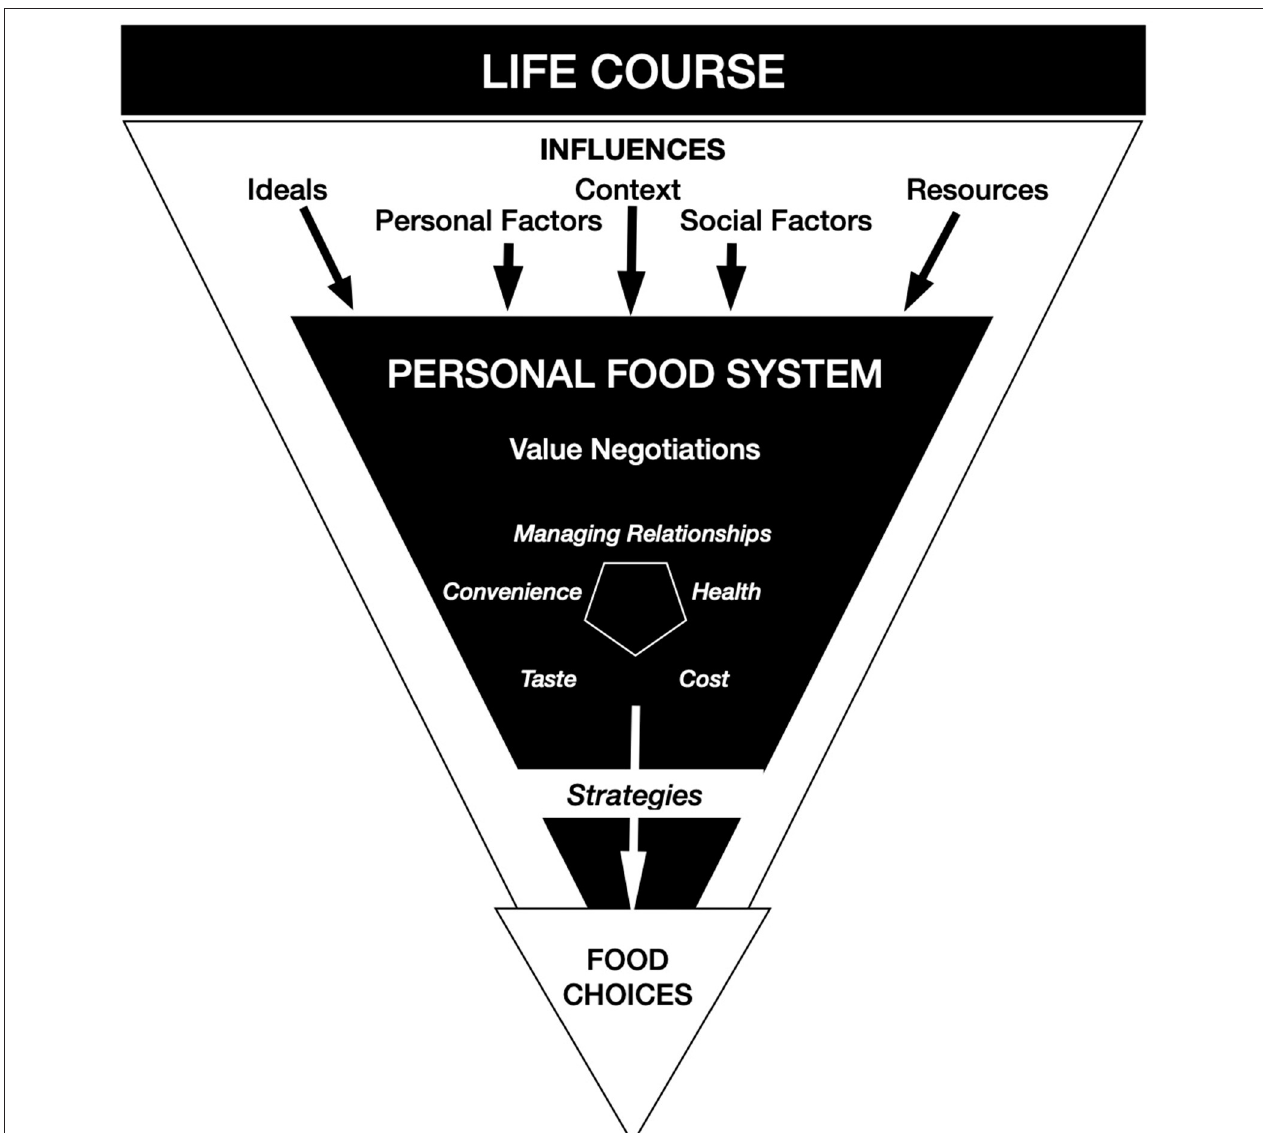
FIGURE 1 | The food-choice process model adapted from Connors et al.